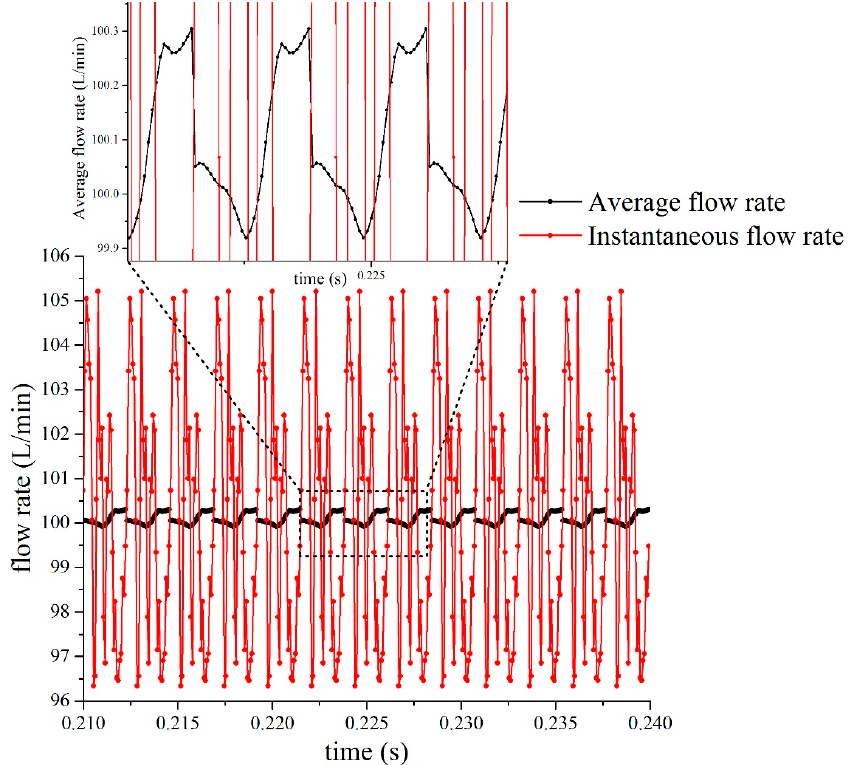
Figure 15. Instantaneous flow rate and average flow rate curves at the outlet of gear pump.